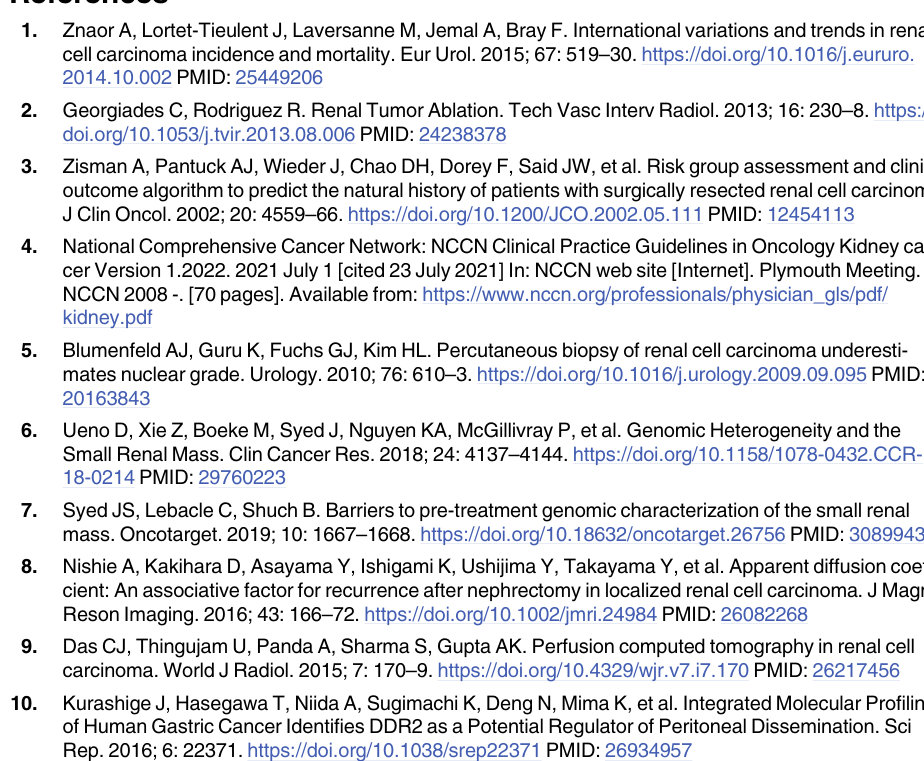
S2 Table. Details of CCP scores, tumor subtypes and imaging parameters to evaluate the relationship with RNA